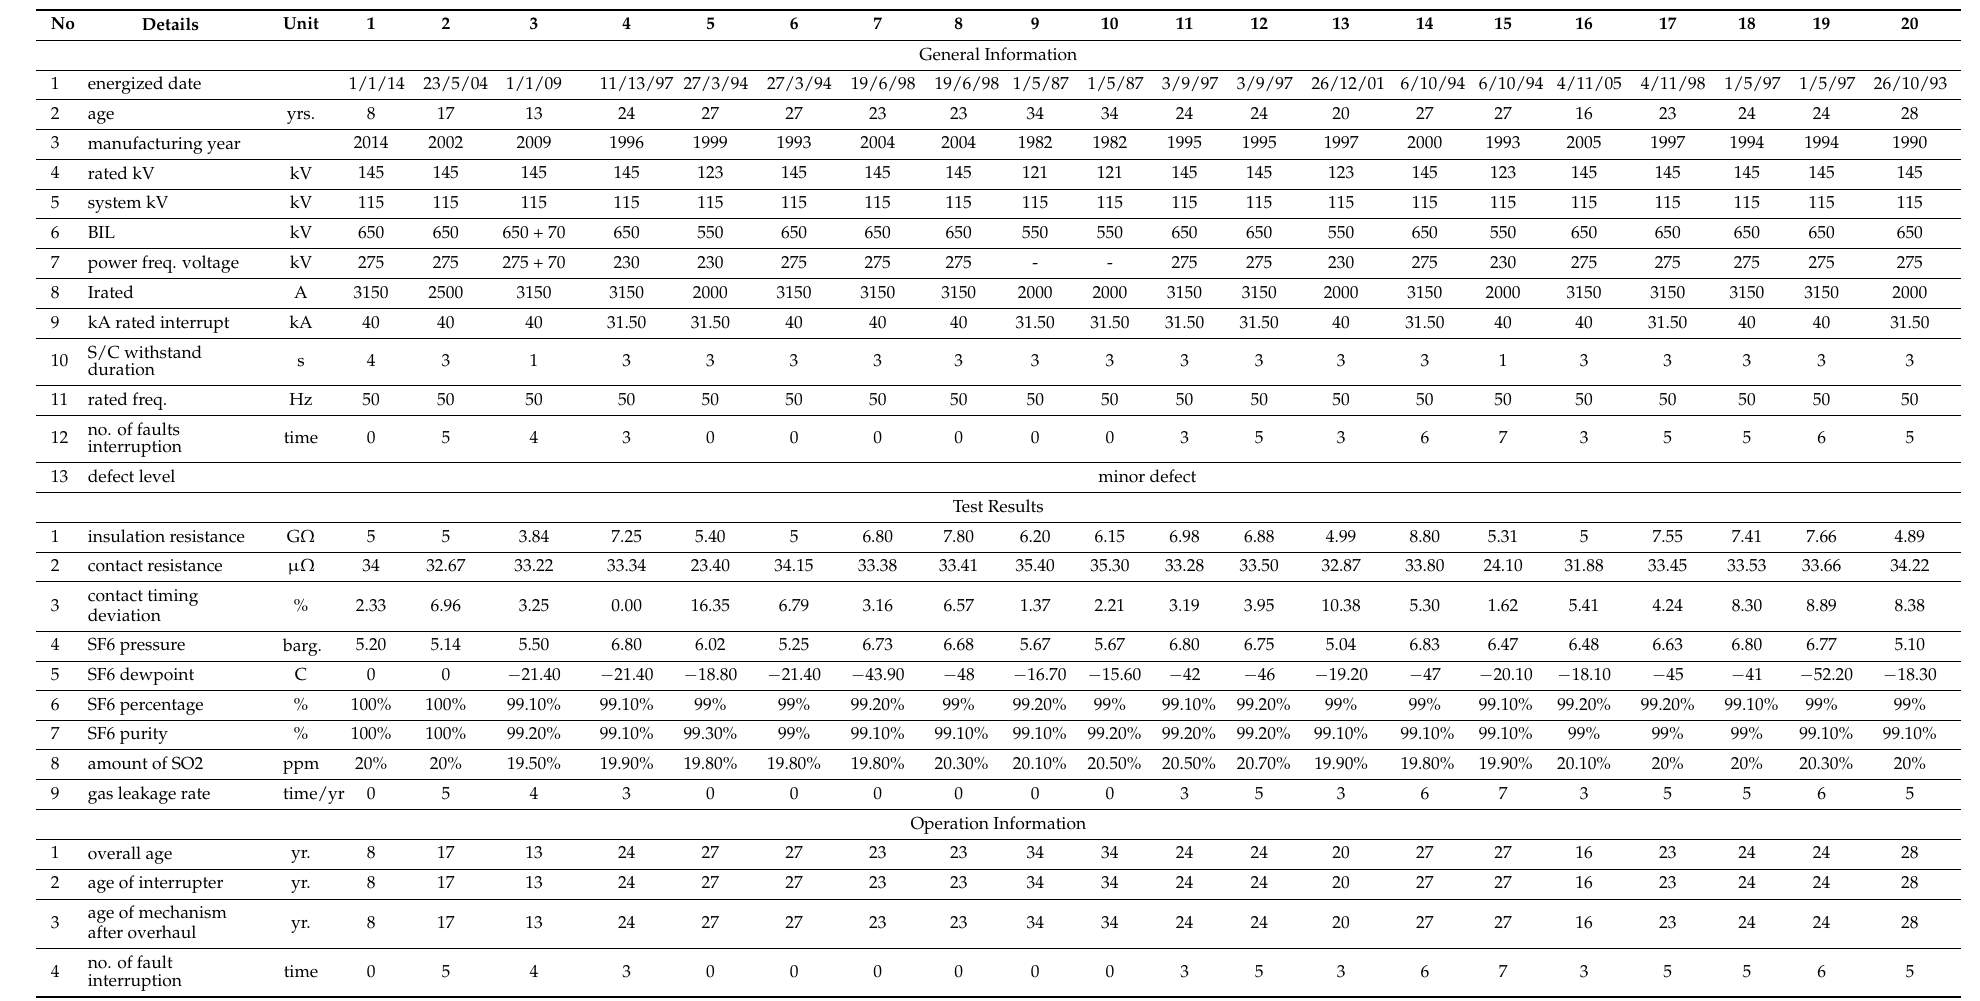
Table 11. Technical specification, test result, and operation information of twenty 115 kV HV circuit